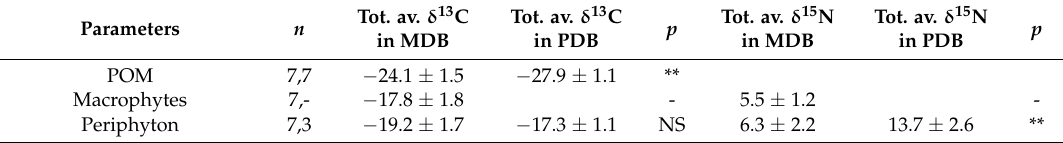
Table A2. Total annual average (tot. av.) carbon isotope ratios ± SD ( δ 13 C) and nitrogen isotope ratios ± SD ( δ 15 N) of analyzed basal carbon resources and consumers in a restored, macrophyte-dominated basin (MDB) and an unrestored, phytoplankton-dominated basin (PDB) of Huizhou West Lake. n = number of measurements over the year; p = significance level of differences between MDB